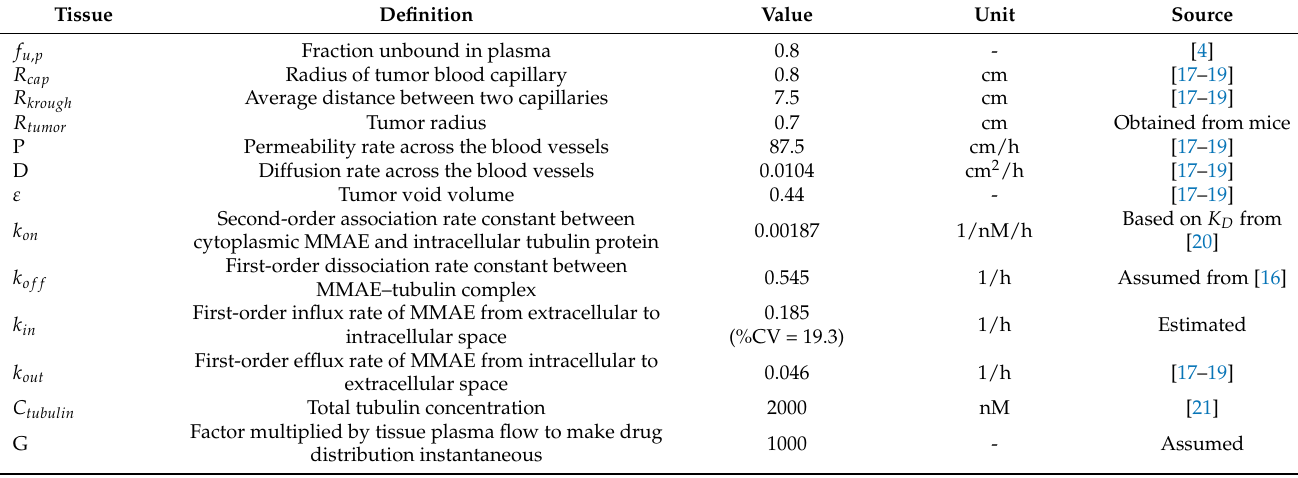
Figure 1. Structure of monomethyl auristatin E (MMAE) physiological-based pharmacokinetic (PBPK) model. ( a ) Structure of the whole-body PBPK model for MMAE. All tissue compartments are connected in an anatomical manner with blood flow indicated by the solid arrows. ( b ) Structure of the tissue level PBPK model for MMAE. Each tissue compartment is divided into the vascular, endothelial cell, interstitial, and cellular sub-compartments. The vascular sub-compartment is further divided into plasma and blood cells. For a detailed description of the symbols and drug disposition processes, please refer to the model structure section in the method section. ( c ) Schematics of the cell-level tumor disposition model for MMAE. For a detailed description of the symbols and drug disposition process, please refer to Table 1 and Model structure section in the Materials and Methods. Table 1. A glossary of literature-derived and estimated parameters used for the MMAE PBPK